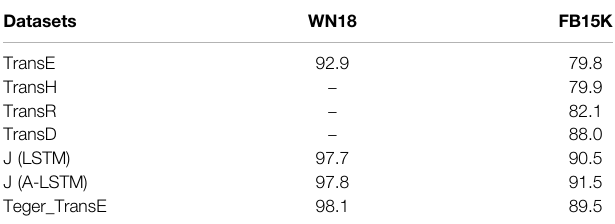
TABLE 5 | Results on triplet classi fi